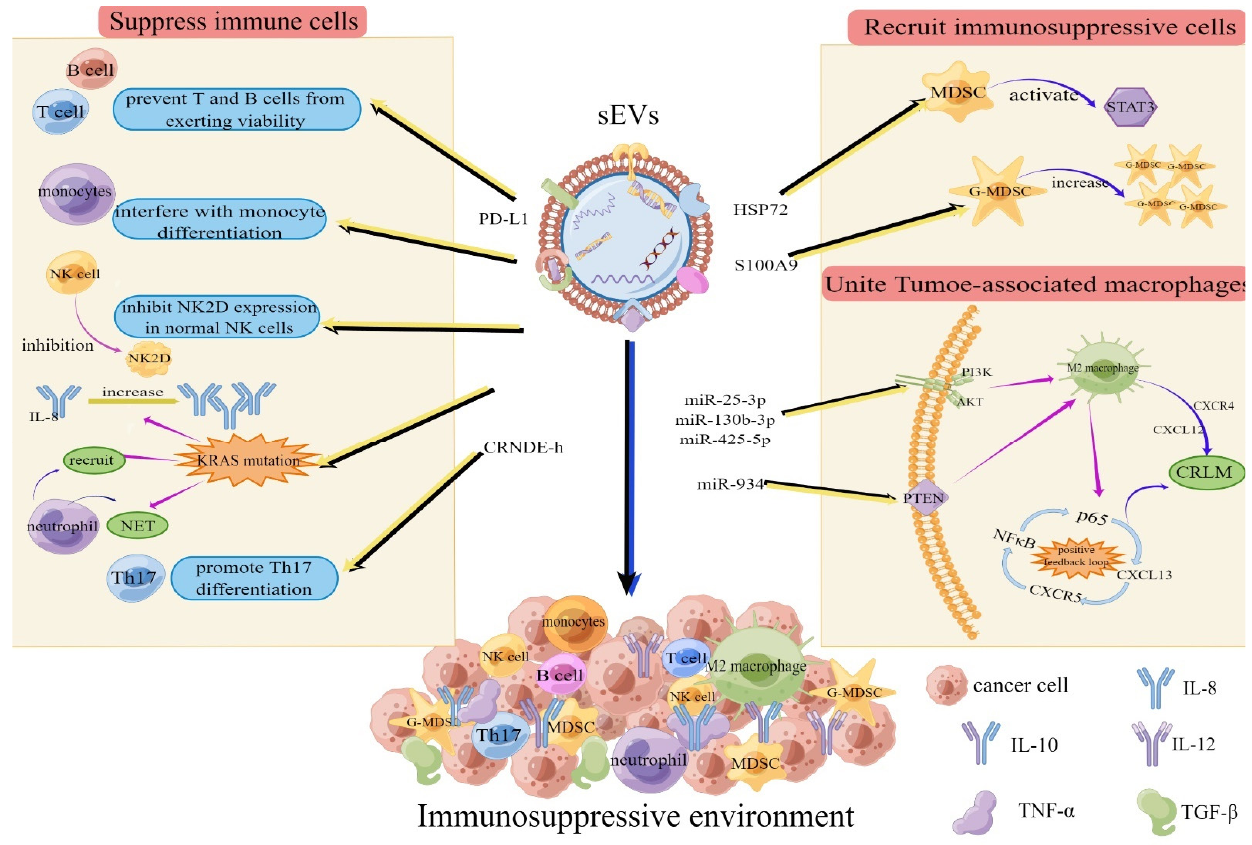
Figure 1. sEVs promote the formation of an immunosuppressive environment. sEVs form an immunosuppressive environment by inhibiting immune cells, recruiting immunosuppressive cells, and combining with TAMs. sEVs inhibit immune cells by PD-L1 causing immune cells to lose the ability to recognize and clear tumor cells, interfering with monocyte differentiation, and inhibiting NK2D expression in normal NK cells. KRAS mutation leads to increased IL-8 production, neutrophil recruitment, and the formation of neutrophil extracellular traps (NET). CONDE-h promotes Th17 cell differentiation. The methods by which sEVs recruit immunosuppressive cells include: HSP72 induces STAT3-dependent immunosuppressive functions of MDSC, and S100A9 promotes G-MDSC proliferation. The methods by which sEVs combine with TAMs are as follows: miR-25-3p, miR-130b-3p, and miR-425-5p induce the M2 polarization of macrophages by activating the PI3K/AK signaling pathway, thereby promoting the CXCL12/CXCR4-induced liver metastasis of colorectal cancer (CRLM). Mir-934 induces the polarization of M2 macrophages by down-regulating PTEN expression and activating the PI3K/AKT signaling pathway; thus, it forms a positive feedback loop of CXCL13/CXCR5/NF κ B/P65/Mir-934 to promote CRLM. Explanation: MDSC: Myeloid-derived suppressor cells, PD-L1: Programmed death-ligand 1.